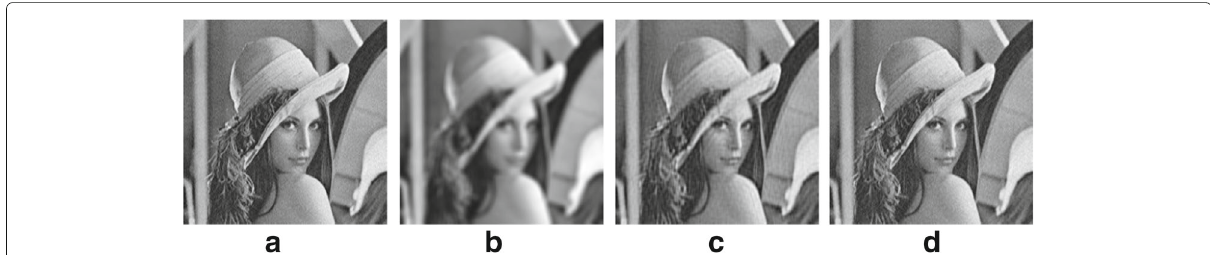
Fig. 13 Analysis of performance for Lena image deblurring: a original image, b acquired image, c FISTA reconstruction MSE (dB) = − 10.718 (after 1000 iterations), d 2-LMM-FISTA reconstruction MSE (dB) = − 13.3958 (after 1000 iterations)